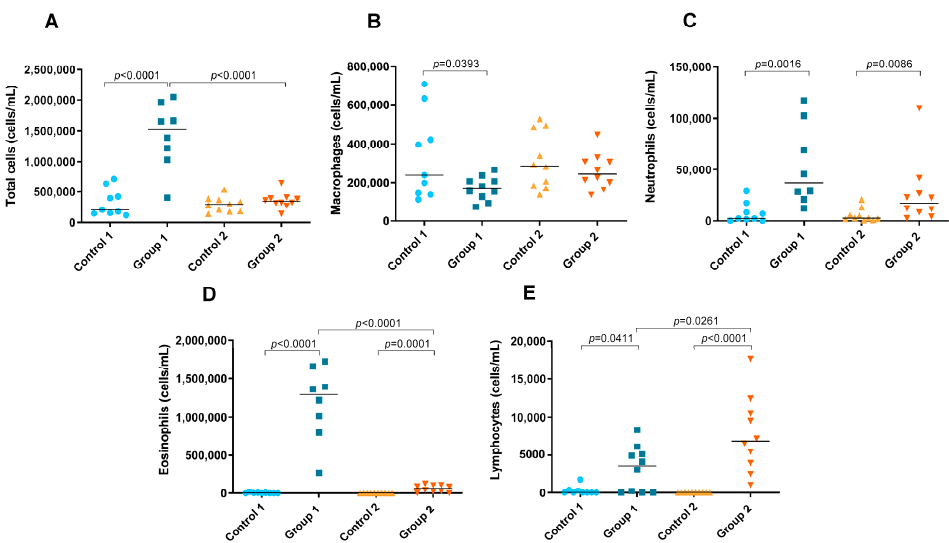
Figure 6. Total and differential cell counts in bronchoalveolar lavage. In each group, data are shown as individual and median values of total cells ( A ), macrophages ( B ), neutrophils ( C ), eosinophils ( D ) and lymphocytes ( E ).